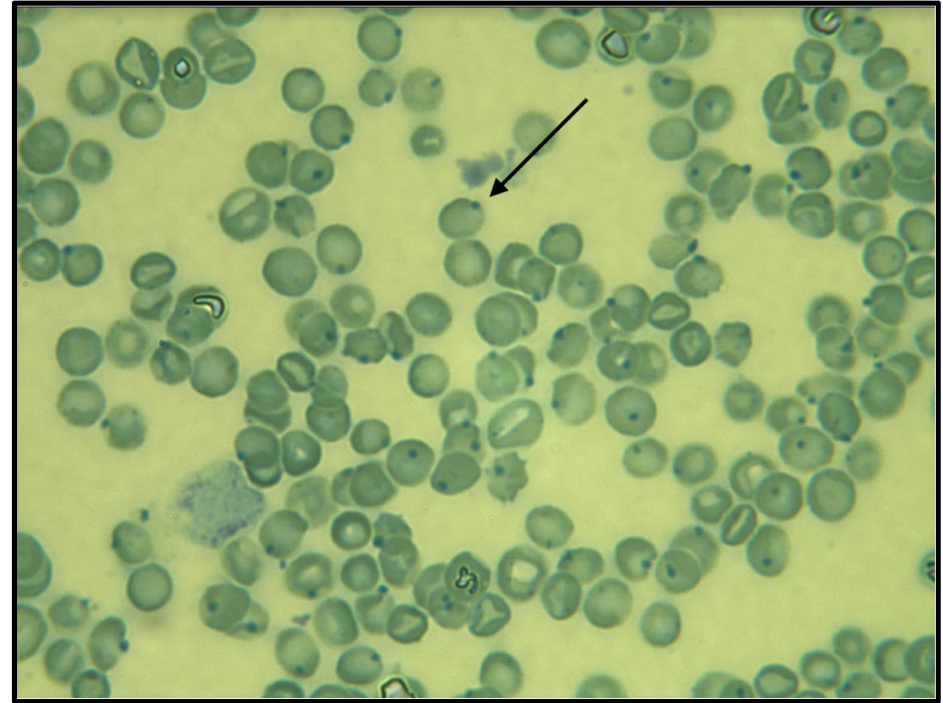
Figure 3. Heinz bodies (arrow) in the blood smear. Blu cresile stain, × 100 objective lens. The diagnostic suspect was acquired methemoglobinemia. The cat was discharged with the indication to avoid stored foods that could contain nitrites/nitrates (e.g., dried meat, canned meat, marinated fish) and to prevent access to toxic substances or drugs (e.g., chlorinated detergents, acetaminophen). It was also indicated to feed the cat exclu- sively with a commercial kitten dry